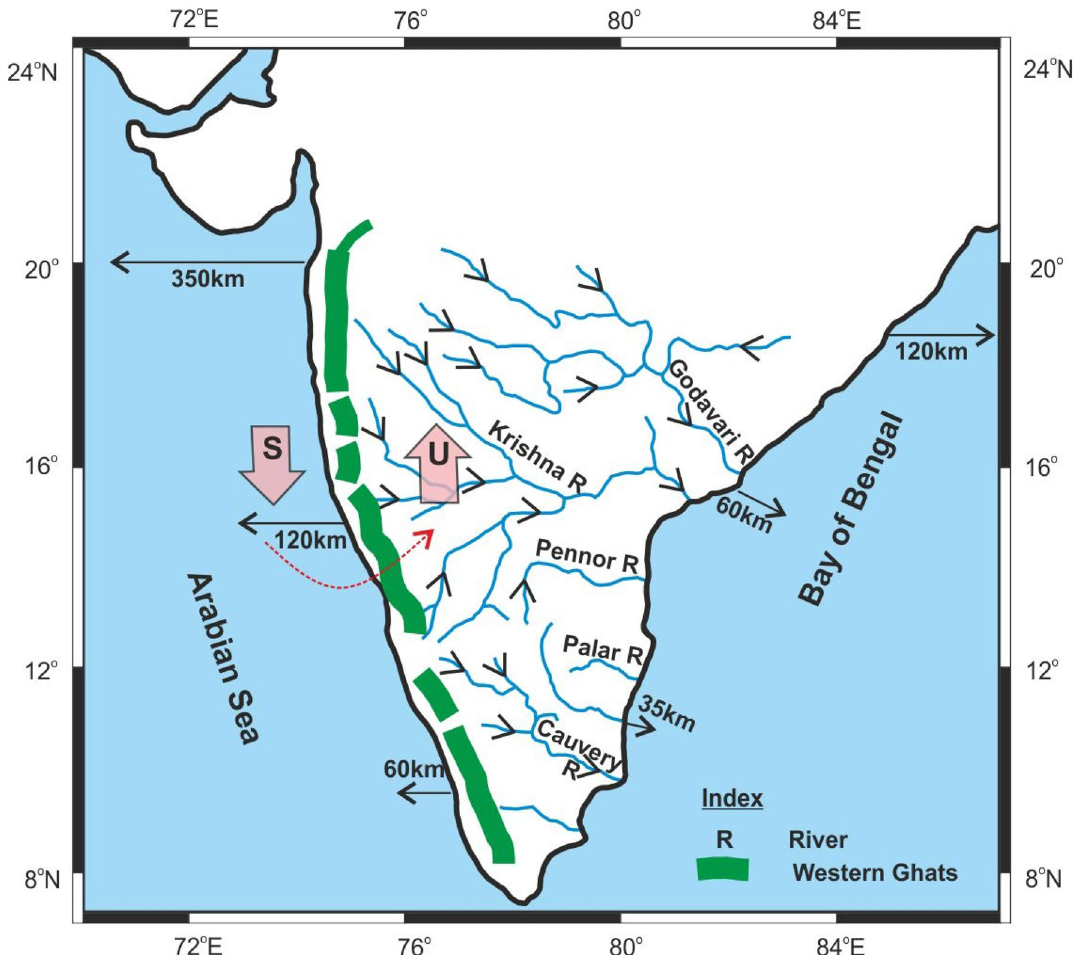
Figure 3. Drainage pattern of peninsular India developed due to mantle plume activity shows asymmetric relief with eastward tilting from 1.5 km high Western Ghats escarpment toward the flood plains of eastward- flowing rivers. Arrows from the coast indicate the width of the continental shelf. The shelf area decreases from north to south and has an area of about 310,000 sq. km 19 in the west and 2493 km long shoreline in the